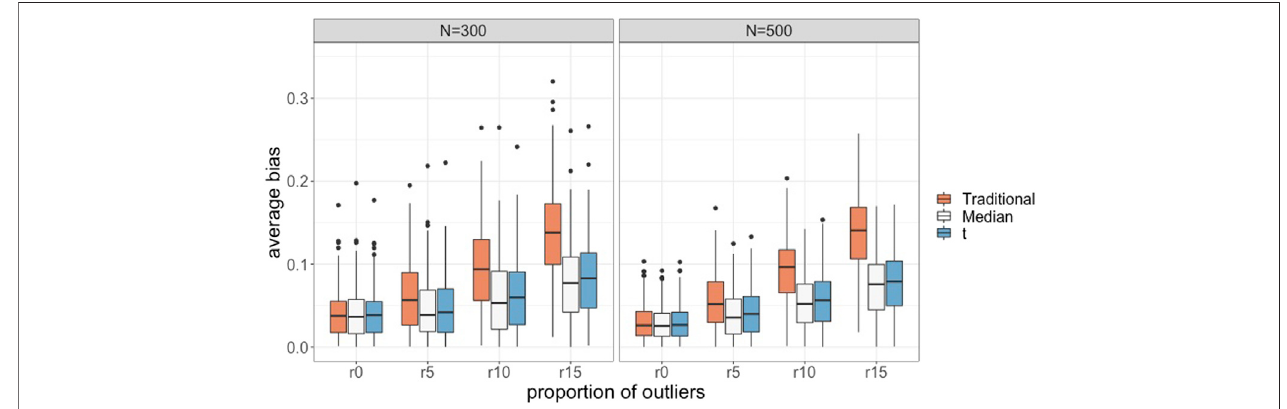
FIGURE 3 | Average absolute bias for the traditional, the median-based, and the t -based GMM in conditions with varied proportions of outliers and sample